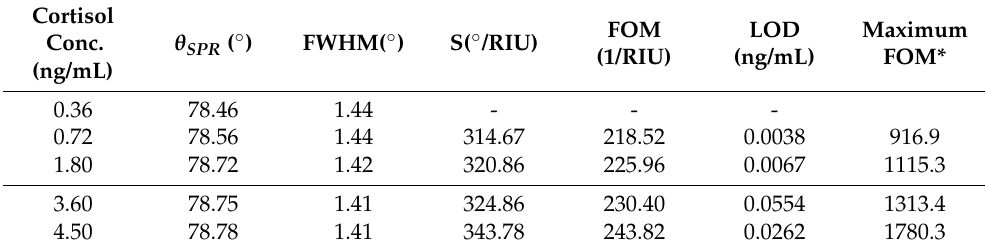
Table 3. Performance parameters at different cortisol